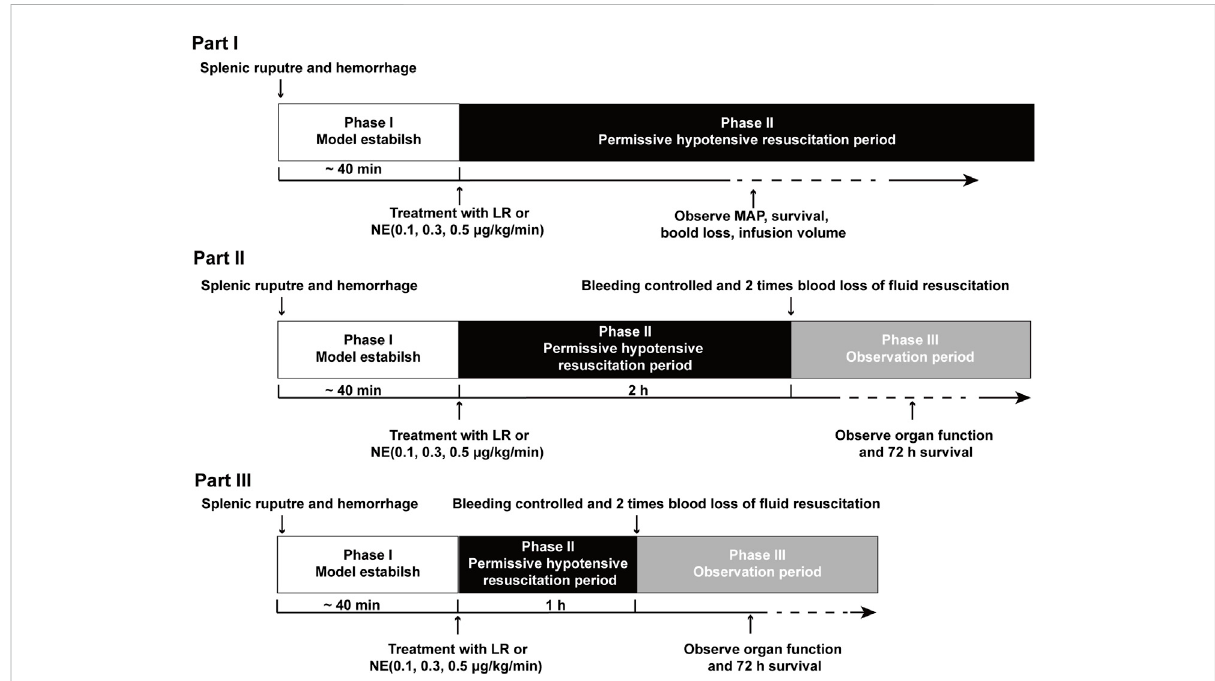
FIGURE 1 Timelineoftheexperimentalphases.PhaseIwastheUHSperiod.PhaseIIwasthepermissivehypotensiveresuscitationperiod.PhaseIIIwasthe observationperiod.PartI:effectsofNEadministrationontolerancetimeduringthepermissivehypotensiveresuscitationperiodbeforebleedingwas controlled following UHS. Part II: the effects of NE on organ function and survival when the splenic artery was ligated after NE administration for 2 h during the hypotensive resuscitation period. Part III: the bene fi cial effects of NE on hemodynamics, organ function, and survival when the splenic artery was ligated after NE administration for 1